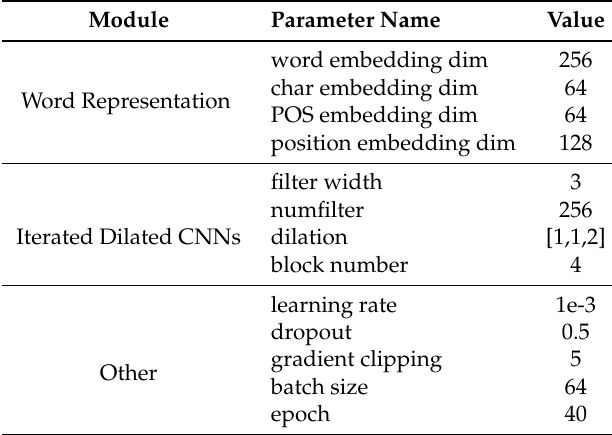
Table 2. Parameter setting for the modules.